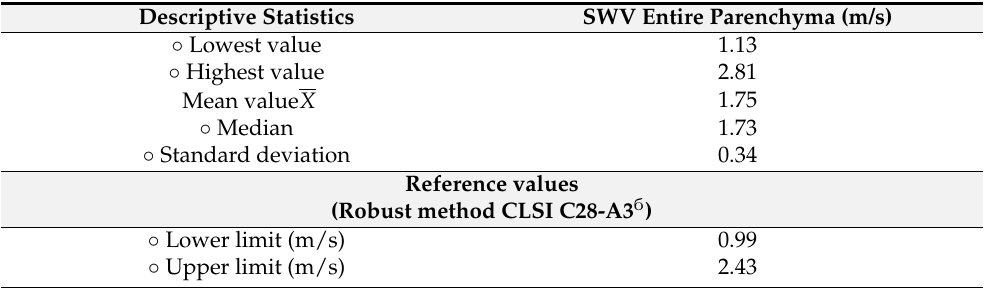
Table 4. SWV values in the CP group (entire